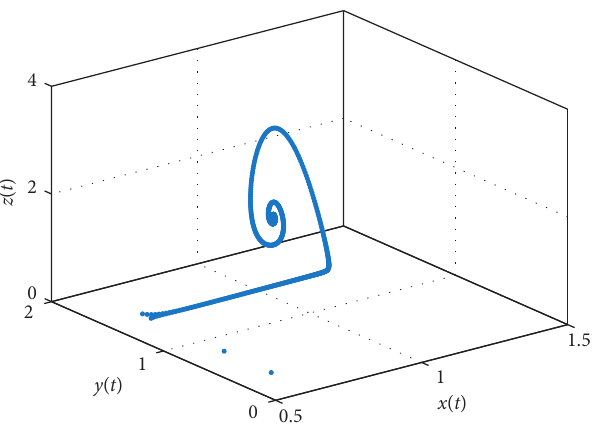
Figure 7: Strange attractors for α